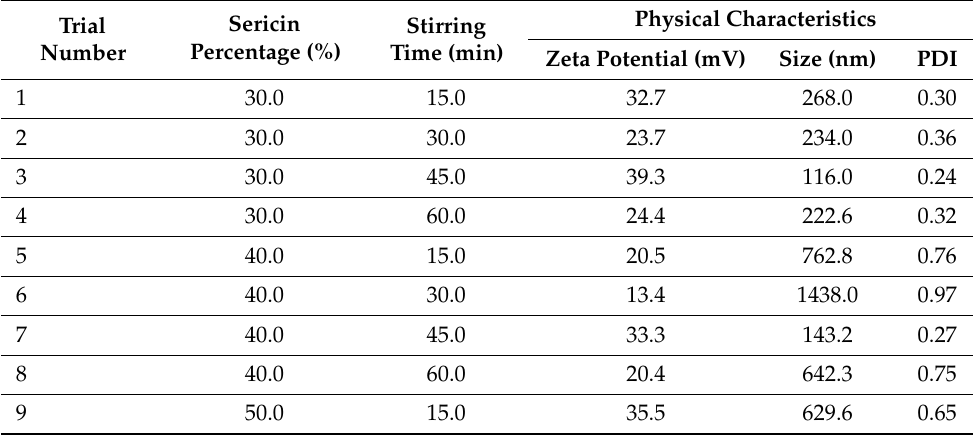
Table 3. Optimization of the physical characteristics of the synthesized